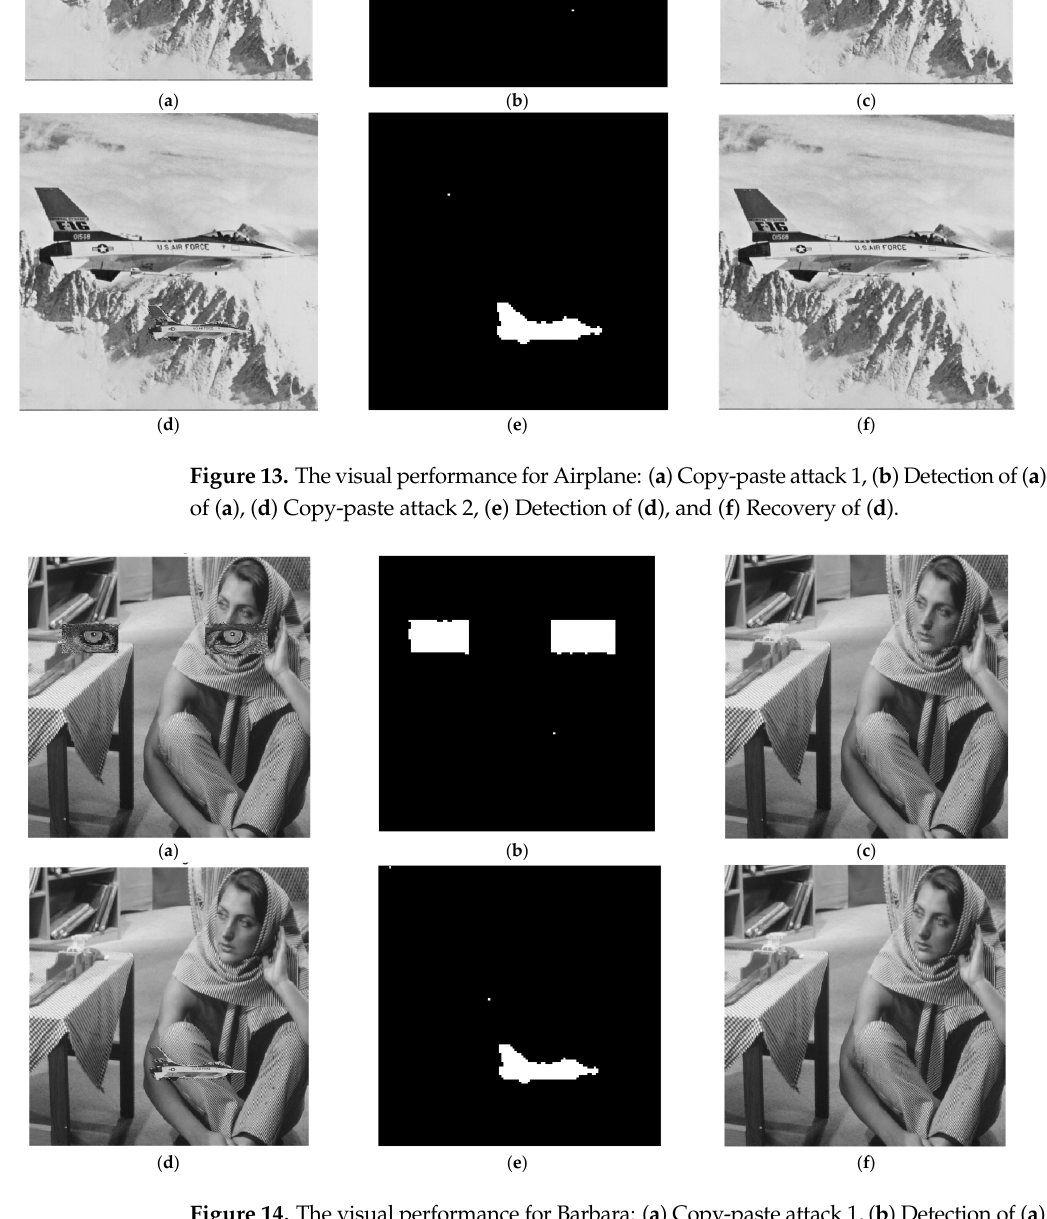
Figure 14. The visual performance for Barbara: ( a ) Copy-paste attack 1, ( b ) Detection of ( a ), ( c ) Re- covery of ( a ), ( d ) Copy-paste attack 2, ( e ) Detection of ( d ), and ( f ) Recovery of ( d ).